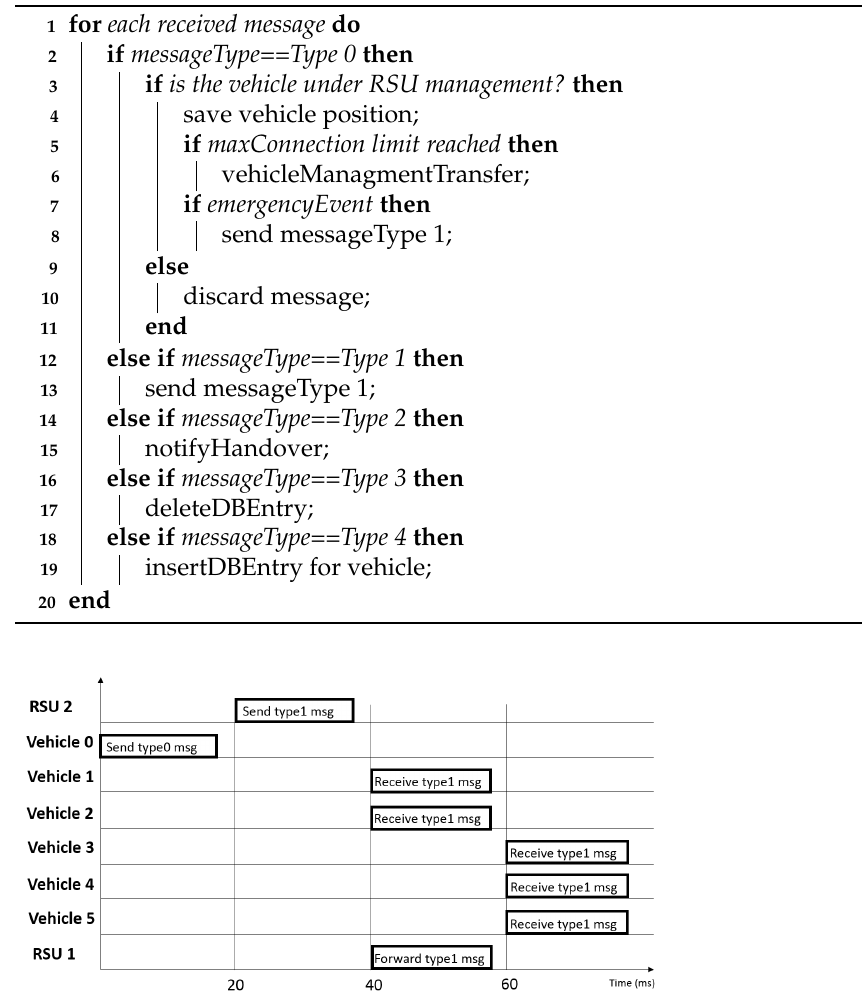
Figure 4. Time diagram of cell breathing-like